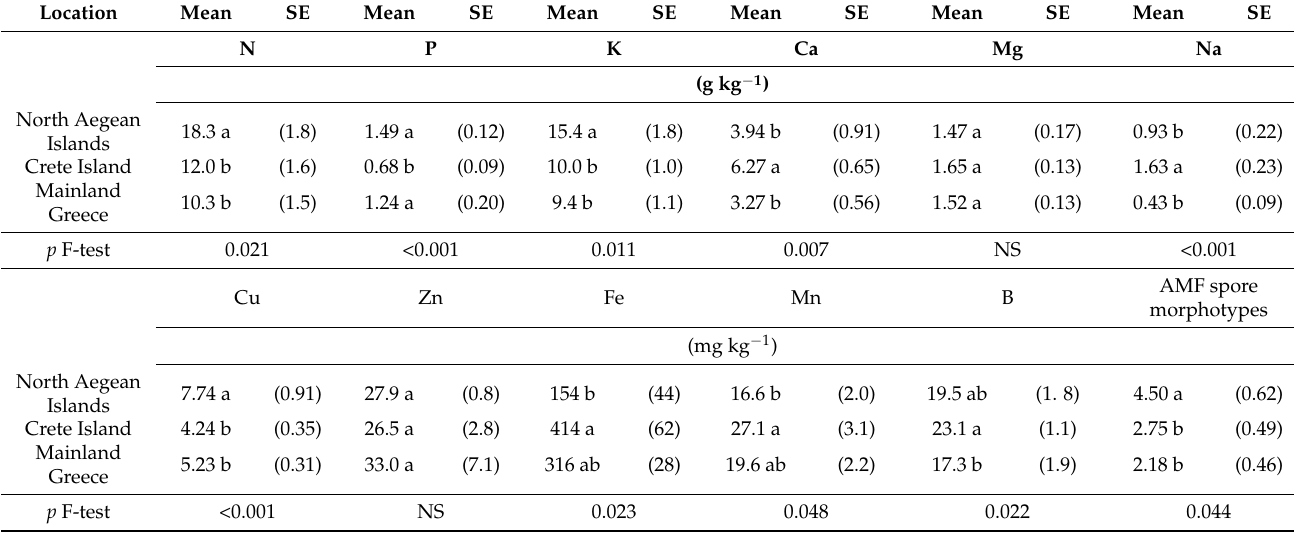
Table 6. Mean values of macro- and micro-nutrients’ concentrations in above-ground biomass of the studied tulip species or fungi morphotypes in terms of their specific phytogeografical unit (Location) namely North Aegean Islands, Crete Island, and mainland Greece. SE: standard error; NS: non- significant. Within each element or arbuscular mycorrhizal fungi (AMF) spores morphotype, different letters indicate significant differences among means, employing the protected LSD test, at p ≤ 0.05.